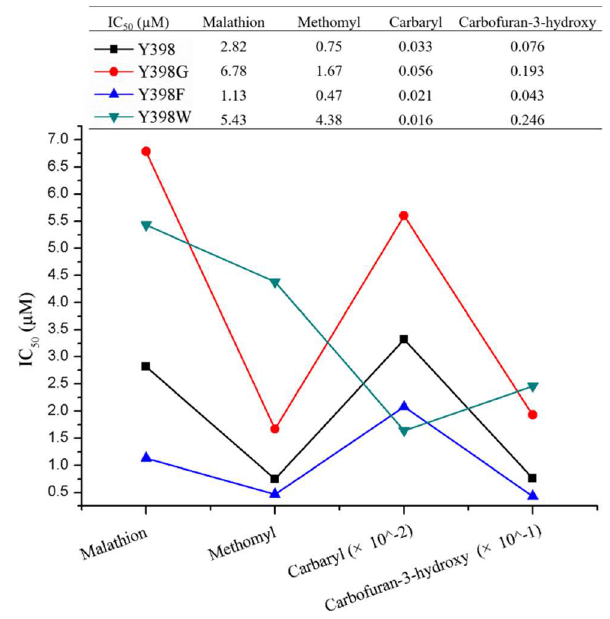
Figure 4. Comparison of inhibition of r Bm AChE II and its mutants by various pesticides.